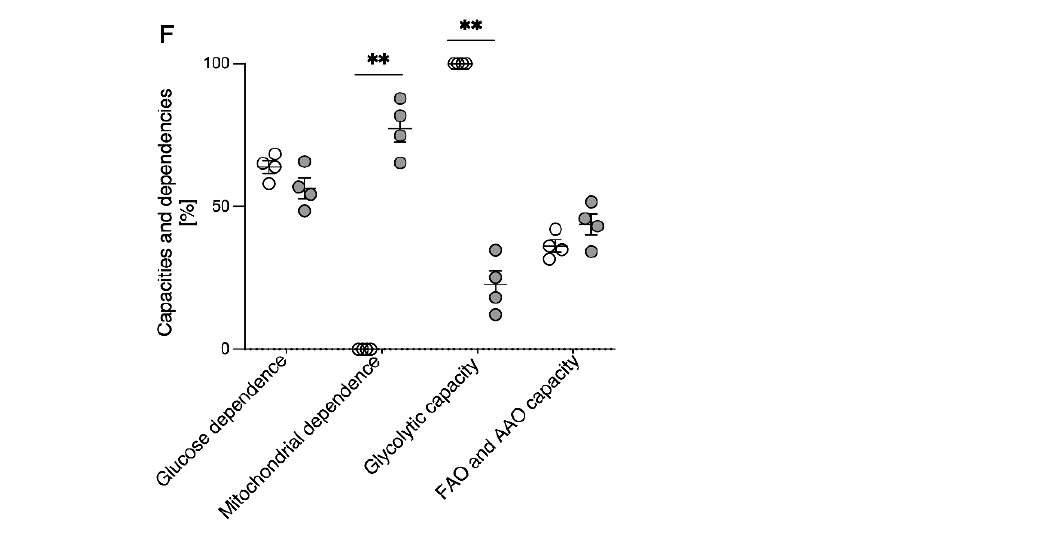
Figure 3. Long-term treatment with Glutor results in an altered phenotype and in a reduced proliferation of NK cells. ( A ) Proliferation of Glutor-treated (100 nM) in comparison to control-treated NK cells. Absolute cell count was calculated at indicated time points: n = 4. Data were pooled from four independent experiments and each experiment was performed with one donor. Mean with SEM. Statistics: paired t -test. ( B ) Expression level of HK1 and pmTOR on Glutor-treated (100 nM) and control NK cells was analyzed using flow cytometry at day 0, day 2, day 4 and day 7: n = 6. Data were pooled from four independent experiments and each experiment was performed with one donor. Mean with SEM. Statistics: paired t -test. ( C ) Expression level of several surface molecules was analyzed on day 21 of long-term treated NK cells (100 nM Glutor or 0.1% DMSO): n = 5. Data were pooled from five independent experiments and each experiment was performed with one